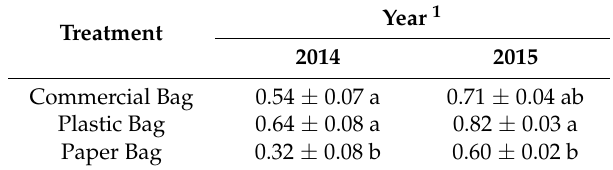
Table 6. Mean ( ± SE) proportion of bags remaining on fruit at